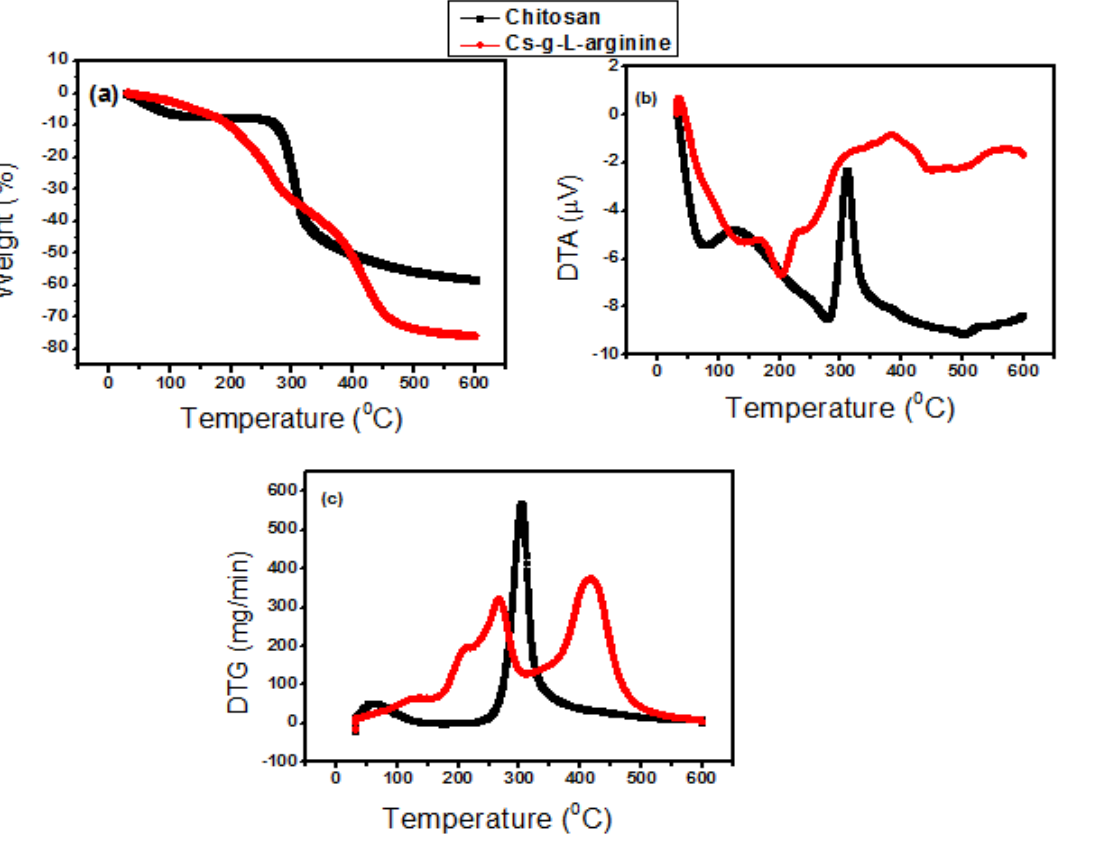
Figure 3. Thermal analysis: ( a ) Thermogravimetric analysis TGA, ( b ) Differential thermal analysis DTA, and ( c ) DTG of chitosan and Cs-g-L-arginine.